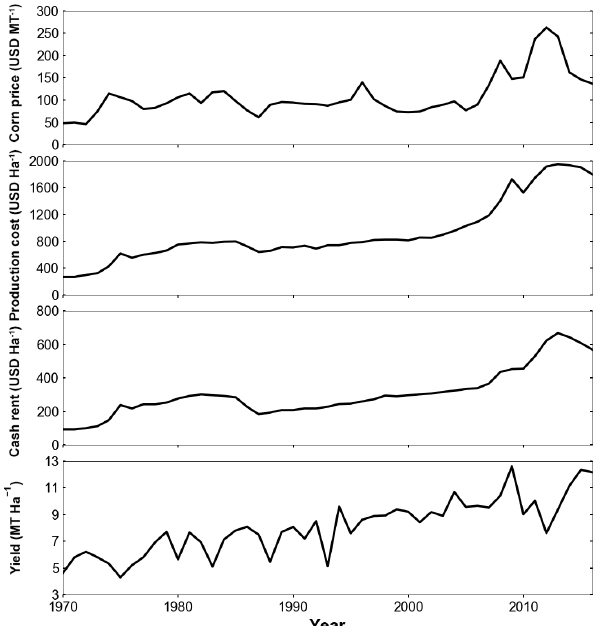
Figure 3. Example input time series of corn price, production cost, and cash rent compared with mean crop